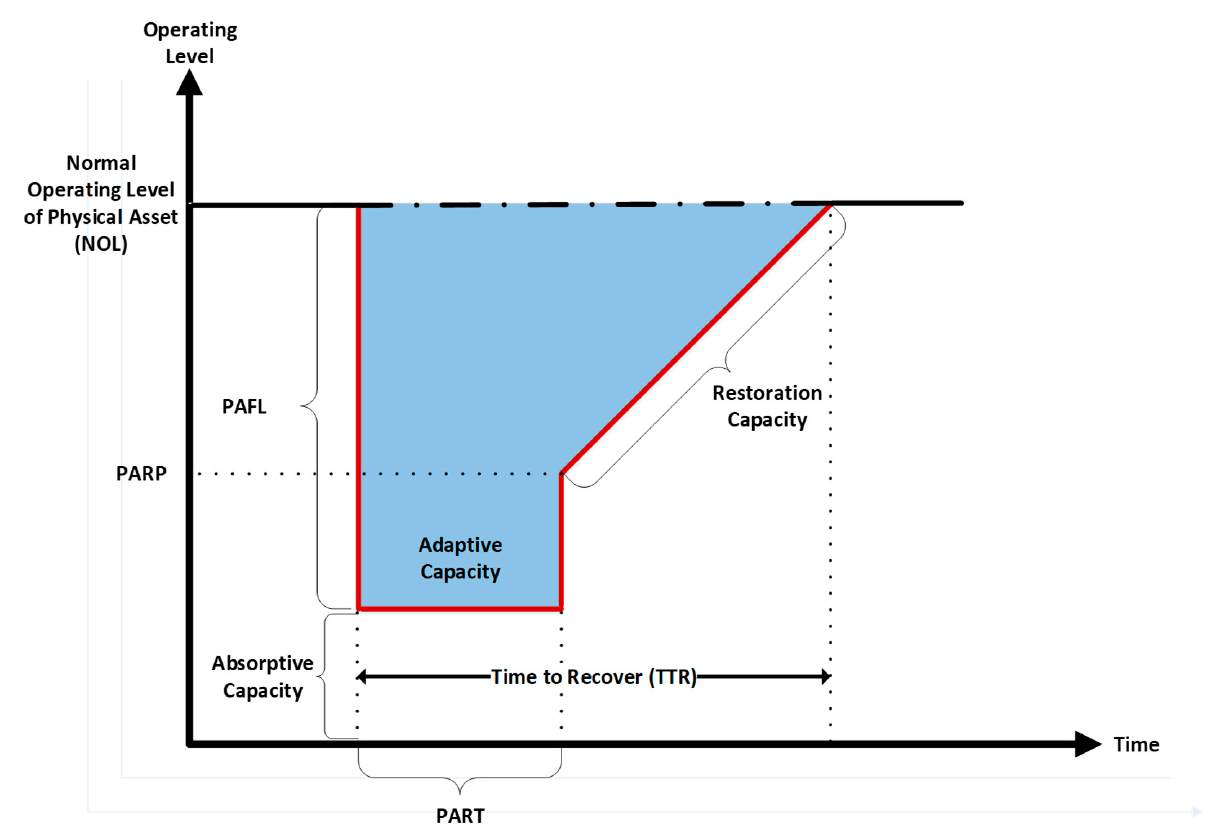
Figure 2. Graphical view of physical assets’ resilience. PARP is the physical asset recovery point, and PART is the physical asset recovery time.